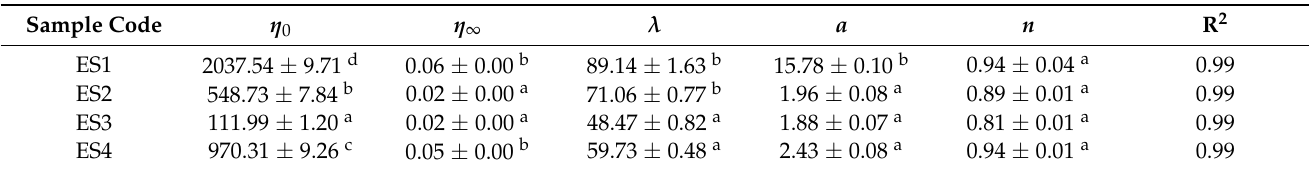
Table 5. Parameters of adjustment of Carreau–Yasuda model of the dressing emulsion stabilized with hydrocolloids from butternut squash seeds at pH